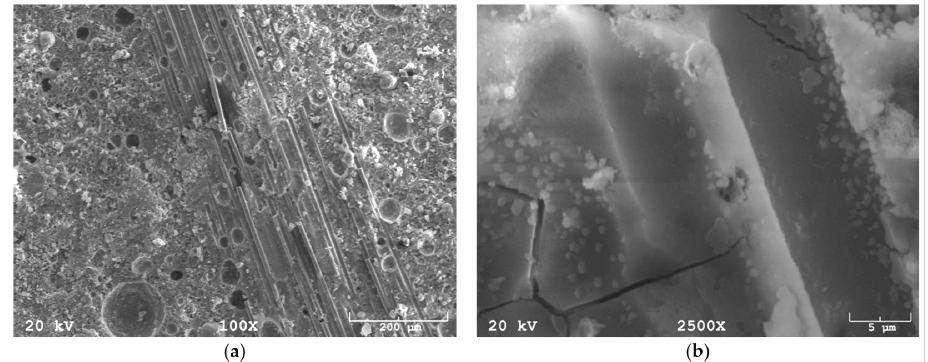
Figure 4. SEM image: ( a ) carbon fiber in a geopolymer matrix—agglomeration, ( b ) composite with the addition of carbon fibers, the photo shows the space left by the carbon